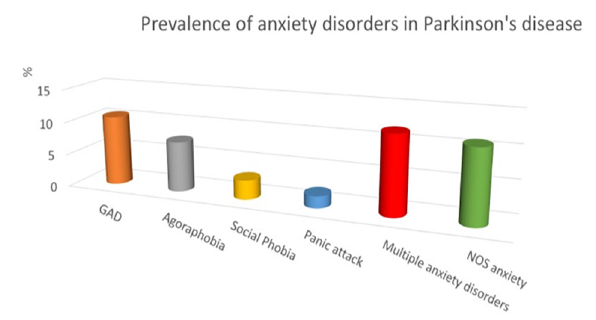
FIGURE 1 | Prevalence of anxiety disorders in Parkinson’s disease (adapted from Leentjens et al., 2011). GAD, generalized anxiety disorder; NOS, not otherwise